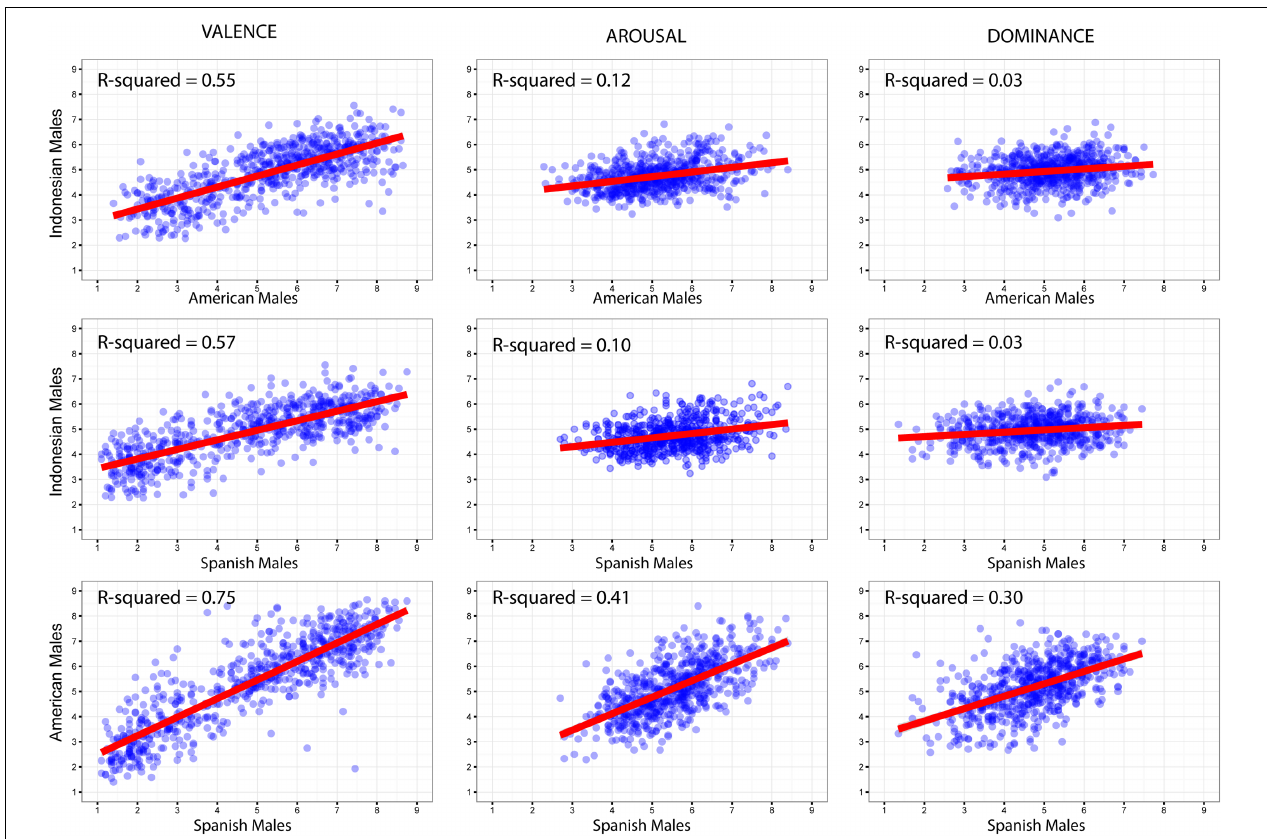
FIGURE 9 | Cross-cultural regression analyses on men’s